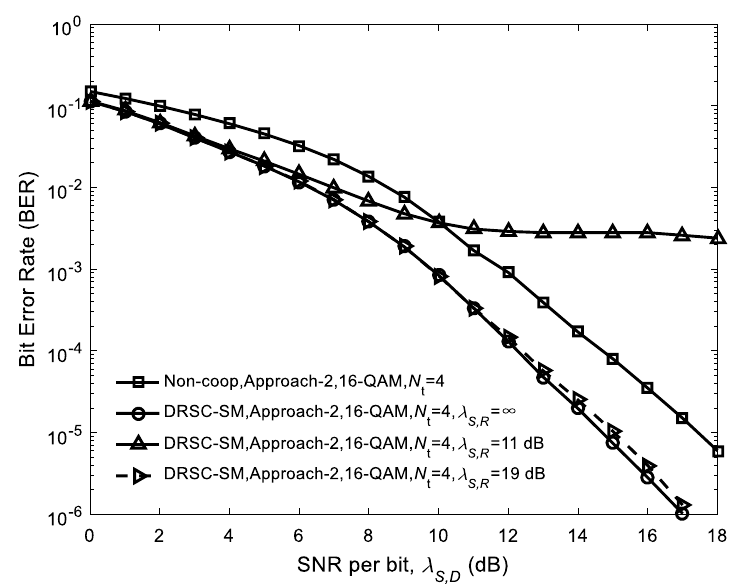
Fig. 14 Performance of DRSC-SM and noncooperative schemes (16-QAM) employing RS 1 ( 63,61 ) and RS 2 ( 63,41 ) . The solid line with upper triangle mark demonstrates the BER performance of DRSC-SM under non-ideal source-to-relay channel ( (cid:31) S , R = 11 dB). The solid line with square mark demonstrates the BER performance of noncooperative scheme. The dashed line with right triangle mark demonstrates the BER performance of DRSC-SM under non-ideal source-to-relay channel ( (cid:31) S , R = 19 dB). The solid line with circle mark demonstrates the BER performance of DRSC-SM under ideal source-to-relay channel ( (cid:31) S , R = ∞ )